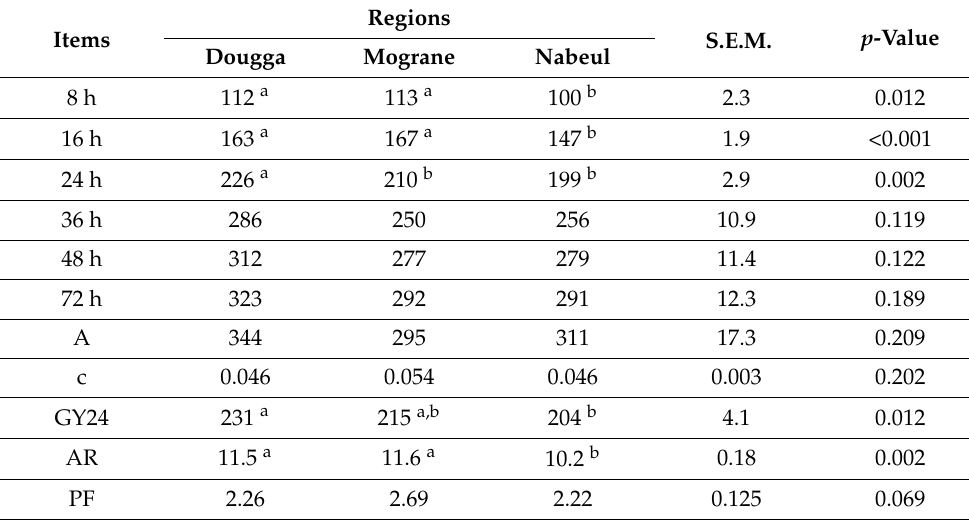
Table 3. In vitro cumulative gas production (mL/g DM) and gas kinetics through 72 h of incubation of Ajuga. iva cultivated in three different regions in